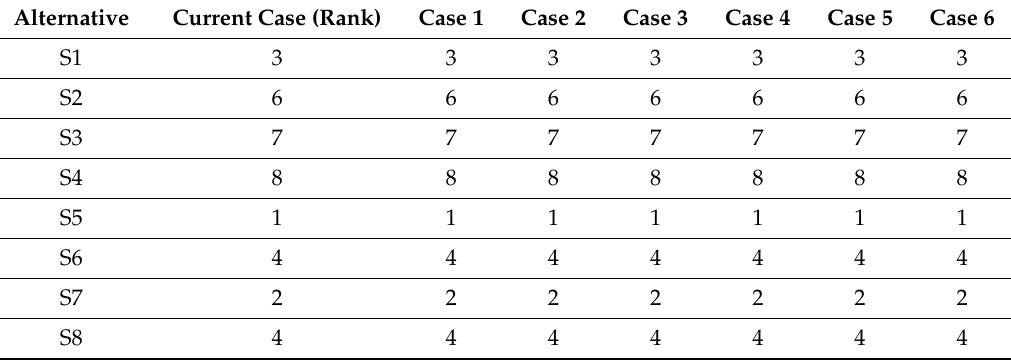
Table 10. Results of the sensitivity